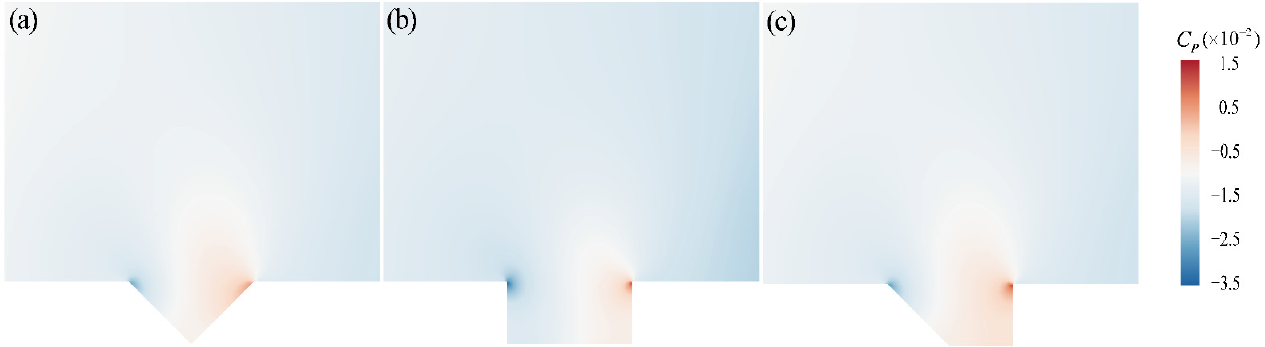
Figure 9. The pressure coefficient distribution near the groove: ( a – c ) the three types of grooves of triangle, rectangle, and trapezoid, respectively.